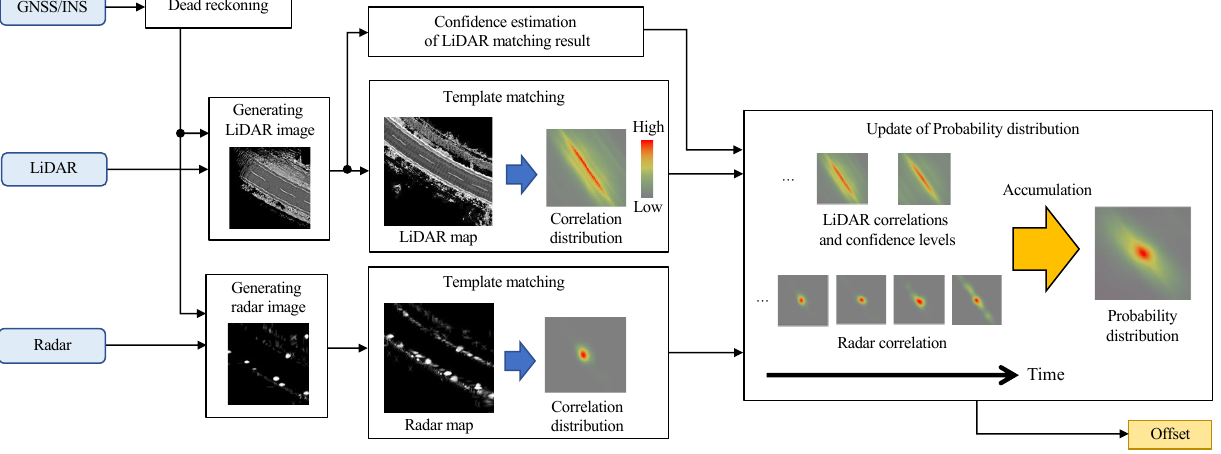
Figure 3. The overview of the localization